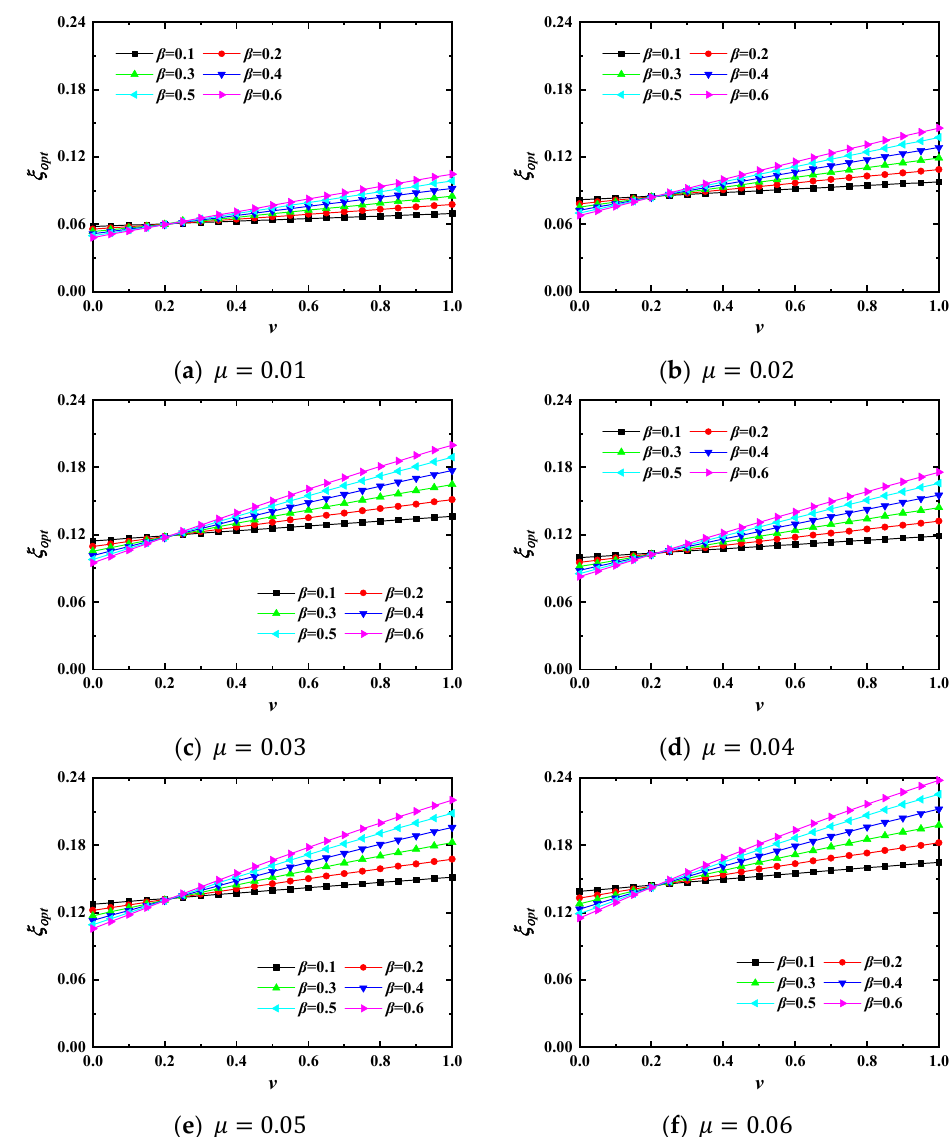
Figure 6. Optimal damping ratio versus suspension location factor with different mass ratios and apparent mass ratios.